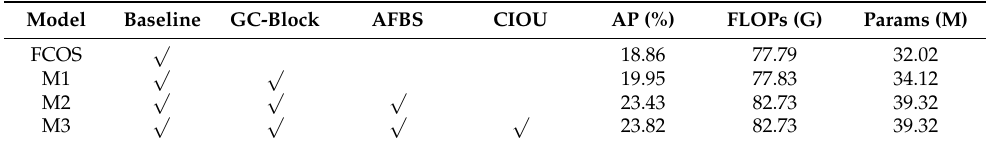
Table 1. Comparison of ablation